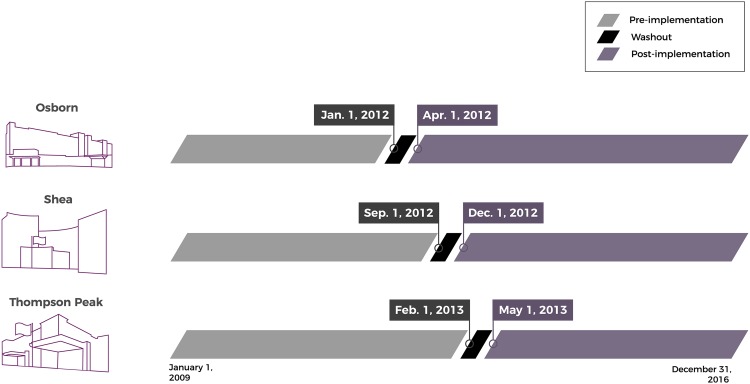
Hip fracture care program implementation timeline.